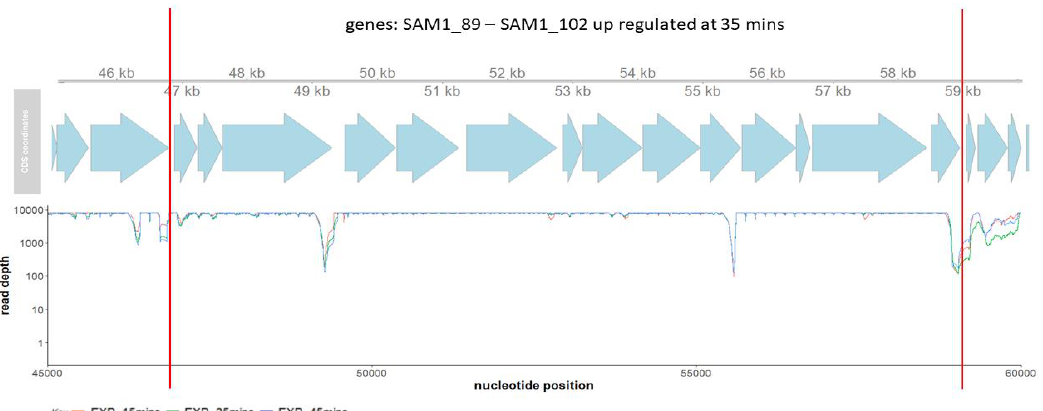
Figure 2. Time course transcriptional response of the genome of Staphylococcus phage SAM1. Values are reported as log2 fold expression change of transcripts from three independent experimental runs taken at time-points 15 min, 35 min and 45 min (15 min was set as a reference level for differential gene expression analysis); only genes with a significantly different expression between any of the time-points are shown ( p < 0.05 in DESeq2, n = 169 (non-redundant genes)).